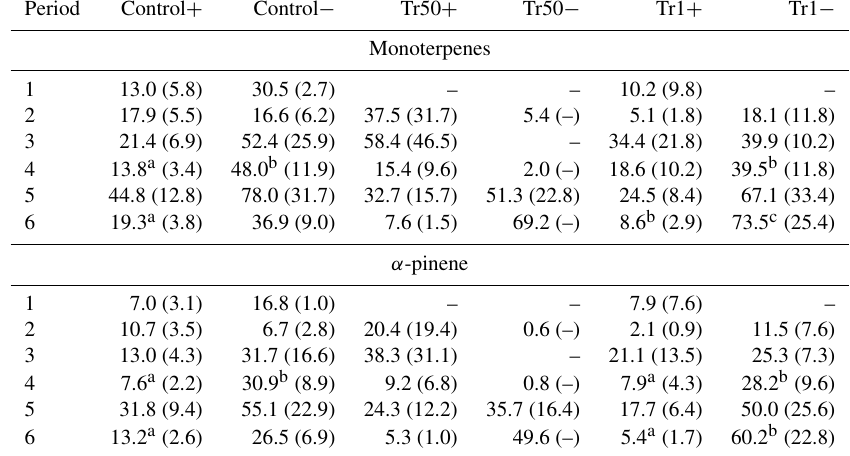
Table 4. Mean (SE) total monoterpene and α -pinene fluxes (µgm − 2 h − 1 ) from different treatments (Control + , Control − , Tr50 + , Tr50 − , Tr1 + and Tr1 − ) during periods 1 to 6, 2015. The periods are (1) 15–24 April, (2) 30 April to 10 May, (3) 21 May to 24 June, (4) 21 July to 21 August, (5) 31 August to 9 October, and (6) 19–23 October. Values were denoted by different letters (a, b, and c) if they differed between treatments within the certain time period (Kruskal–Wallis test; p < 0 . 05).